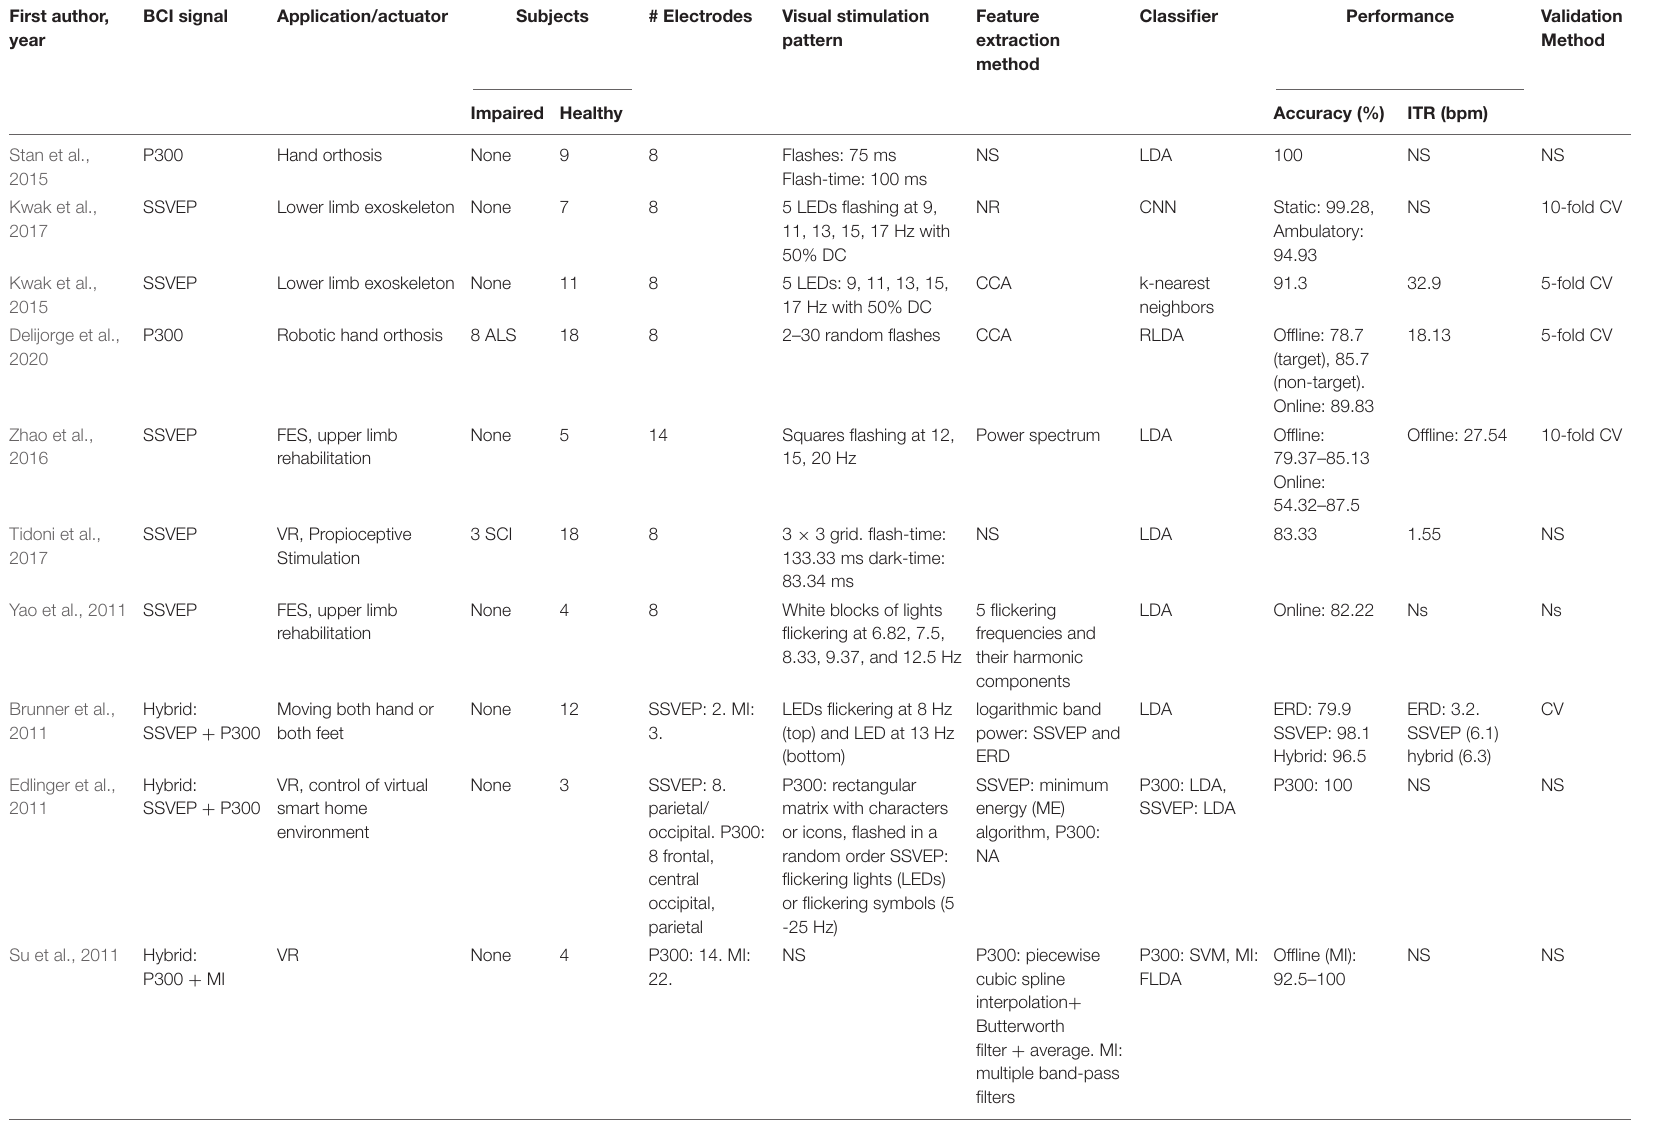
TABLE 1 | Artificial Intelligence Algorithms applied for detection and classification of P300 or SSVEP signals in BCI Applications for motor